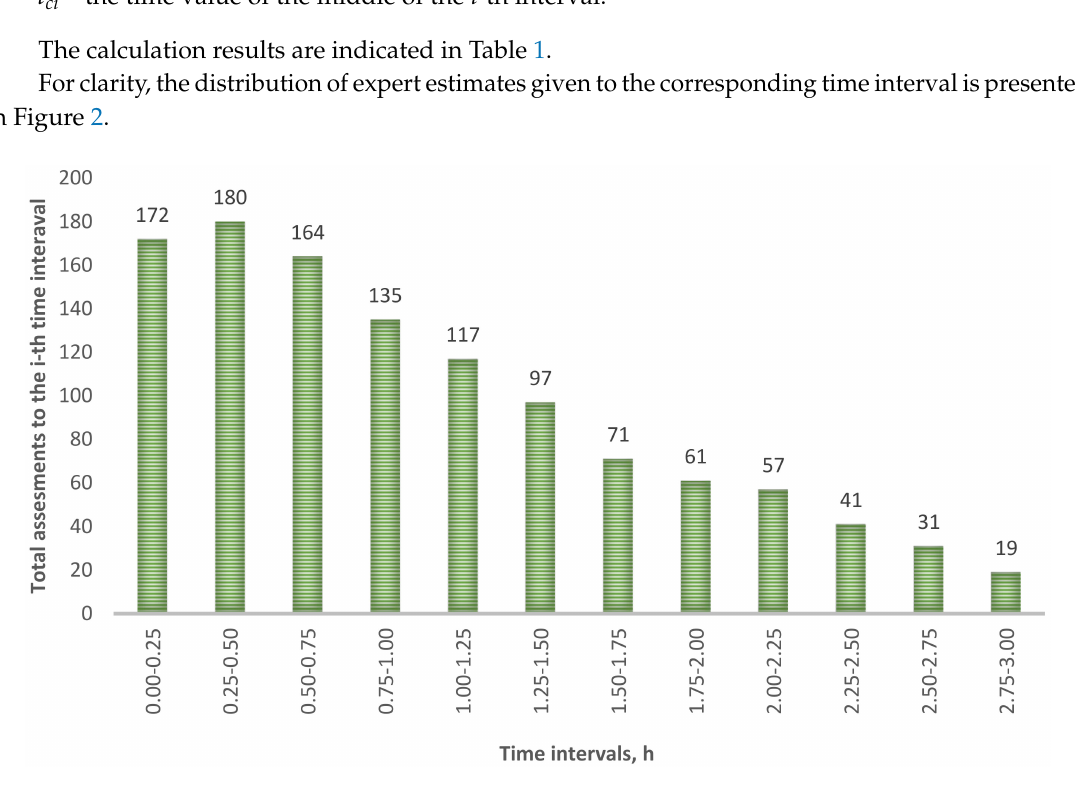
Figure 2. The histogram that represents the assessment of experts concerning a distribution of the time for obtaining information on